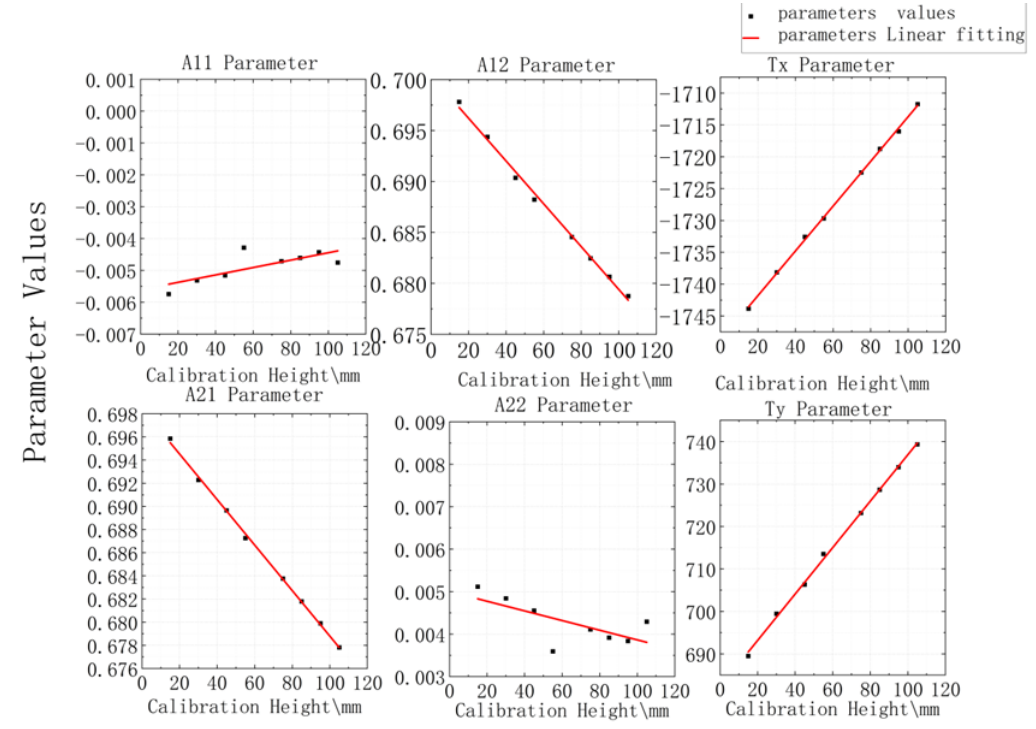
Figure 11. Relationship between rigid transformation parameters and calibration height.